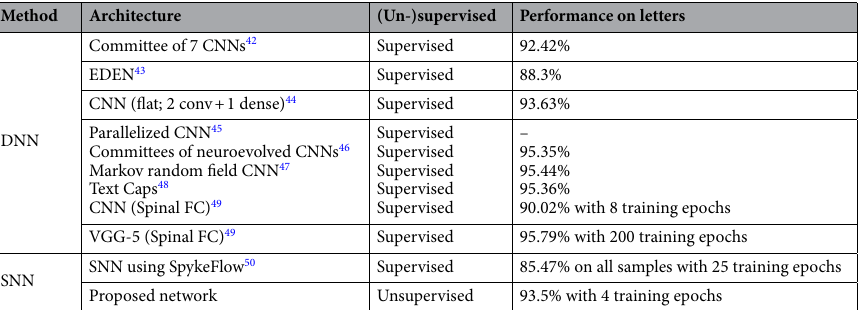
Table 2. Comparison of the classification accuracy in the letters of EMNIST